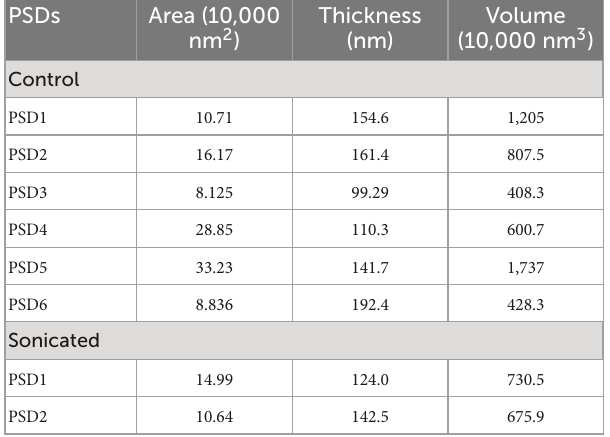
TABLE 1 Areas, thicknesses, and volumes of control and sonicated PSDs. TABLE 2 Volumes and sizes of trans- PSD modules from control and sonicated